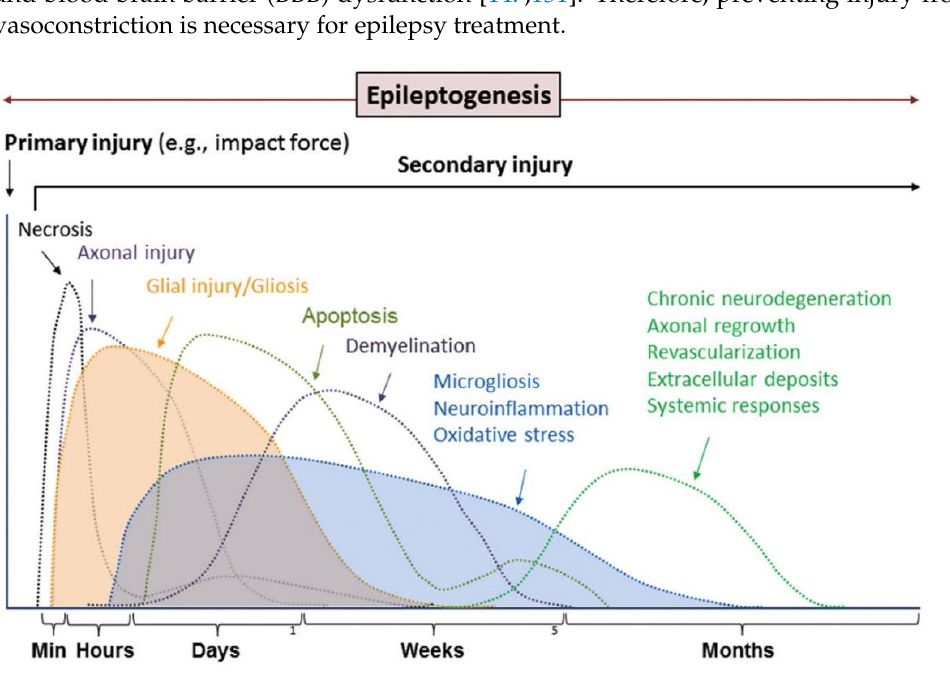
Figure 5. Pathological changes progress and vary with epileptogenesis and the development of epilepsy. Adapted with permission from ref. [146]. Copyright 2019 Elsevier.